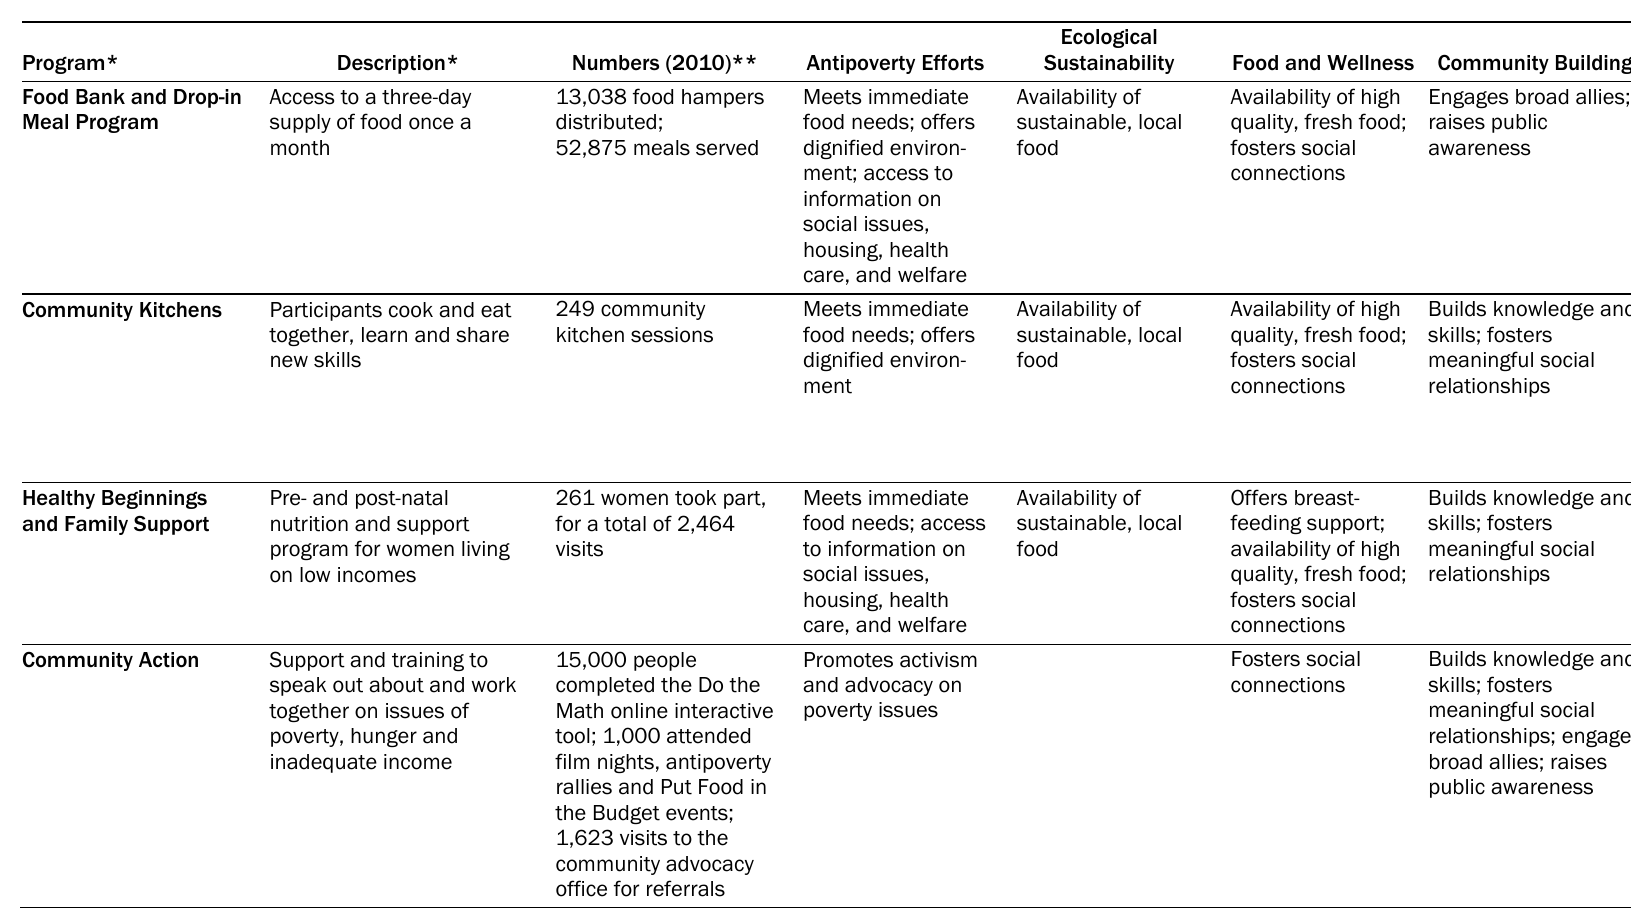
Table 1. The Stop CFC Program